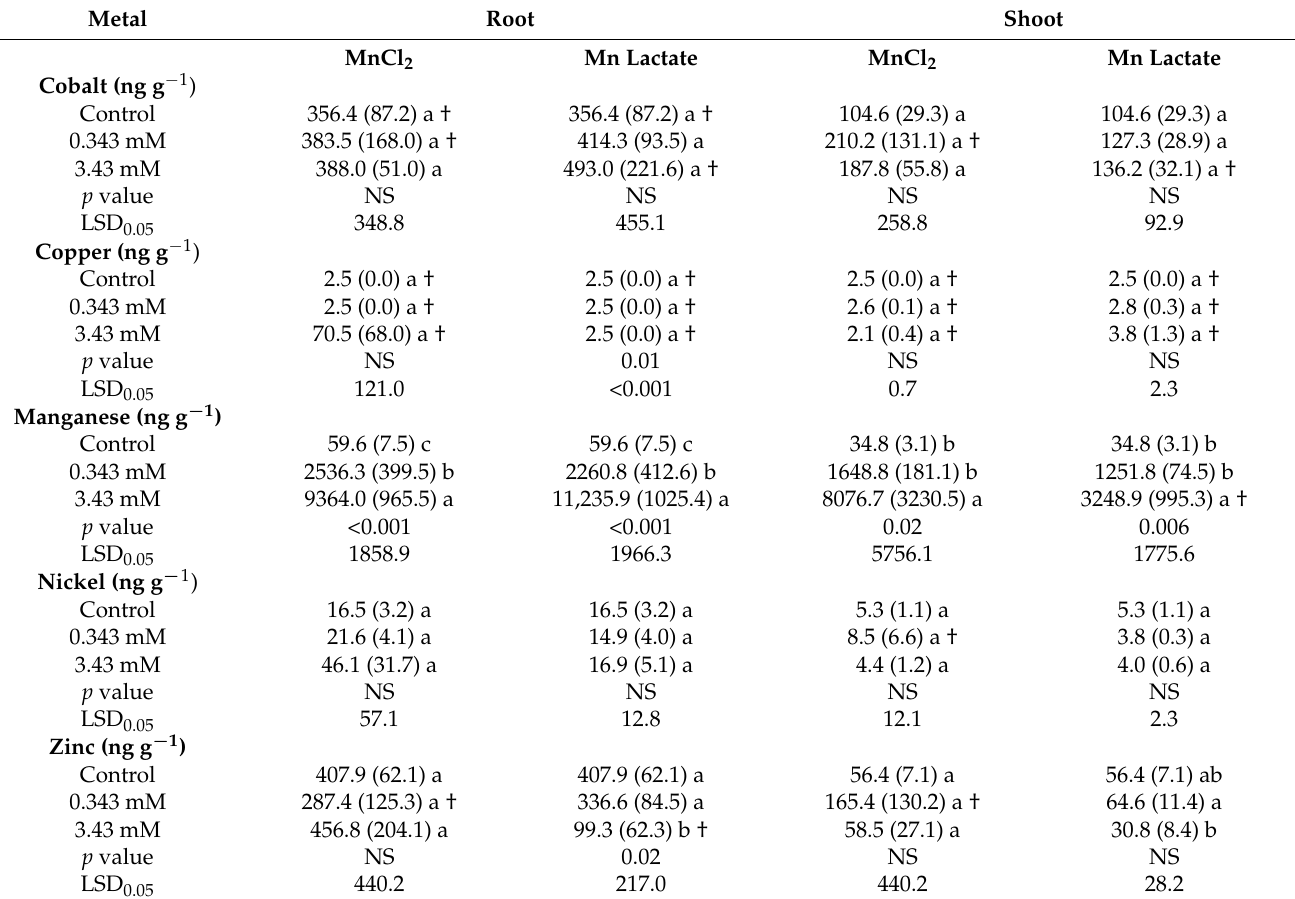
Table 4. Mean concentration of Co, Cu, Mn, Ni and Zn in the root and shoot tissues of wheat grown with manganese chloride or manganese lactate. Control samples did not receive any manganese supplementation. Different letters indicate a statistically significant difference between treatment concentrations and control ( p < 0.05; Fisher’s LSD Test). The “†” symbol indicates that the mean was derived from one or more replicates with metal concentrations below the instrument detection limit (DL) and were substituted with values equal to the DL/2. No significant differences in tissue metal concentrations were detected between manganese chloride and manganese lactate at any concentration for any metal analyzed ( p < 0.05; simple t -test). Standard error is denoted in parenthesis; n = 5. NS: not